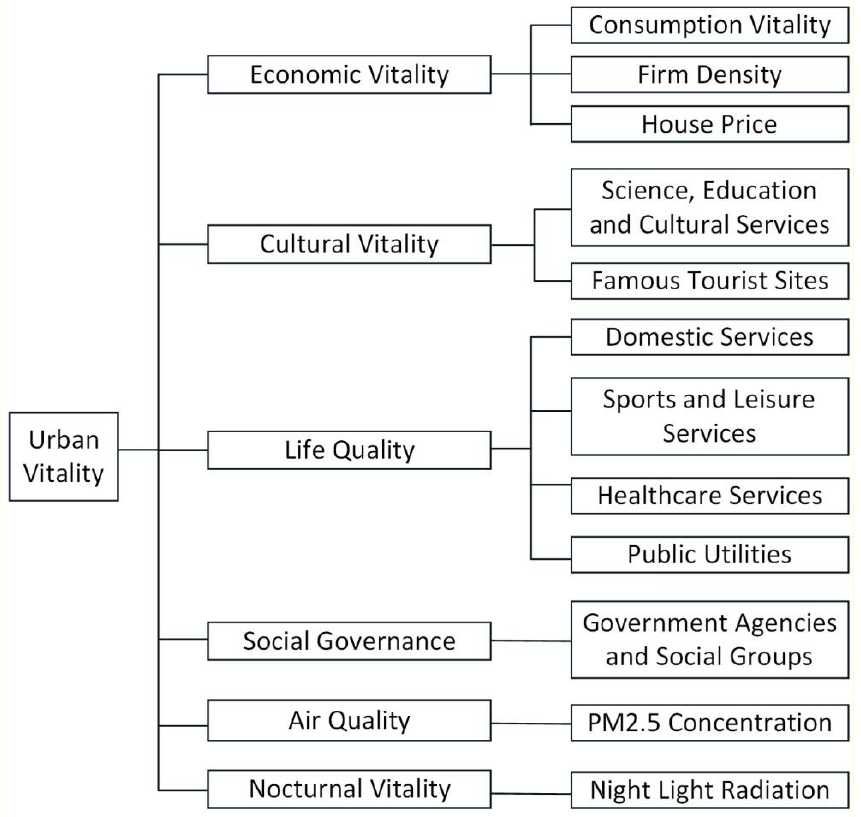
Figure 2. Urban vitality index system.